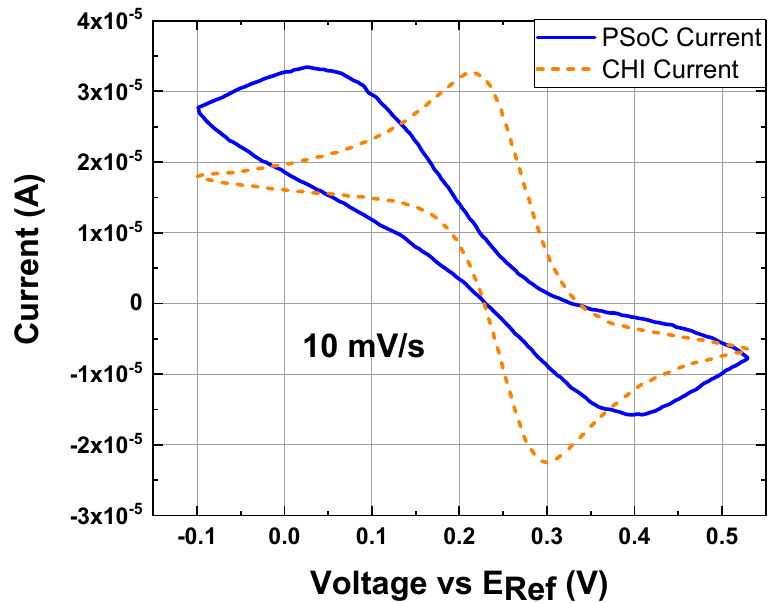
Figure 9. Cyclic voltammetry at 10 mV/s, 10 mM K 3 [Fe(CN) 6 ] and 0.5 M KCl as the electrolyte support; the working electrode, the counter electrode and the reference electrode were a disk glassy carbon electrode (diameter φ = 3 mm), a platinum wire and Ag/AgCl electrode, respectively; experiment under the conditions 16: (Blue line) CV response by the EPS. (Orange line) CV response by the commercial potentiostat.